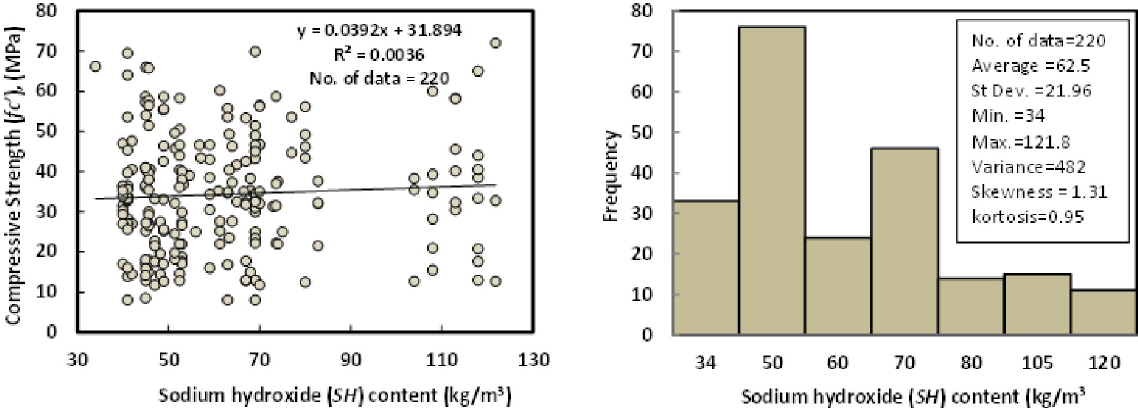
Fig 9. Relationship and a histogram of compression strength and sodium hydroxide content of GGBS/FA-GPC.